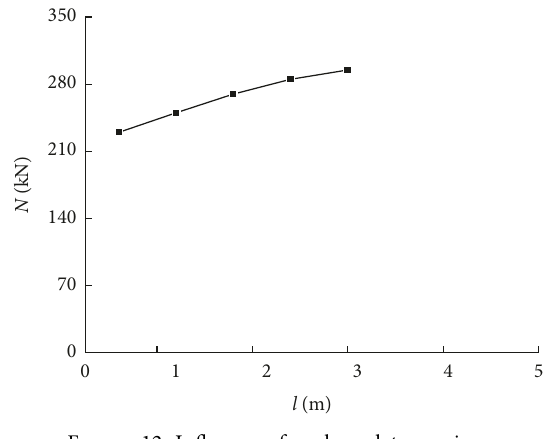
Figure 12: Influence of anchor plate spacing.